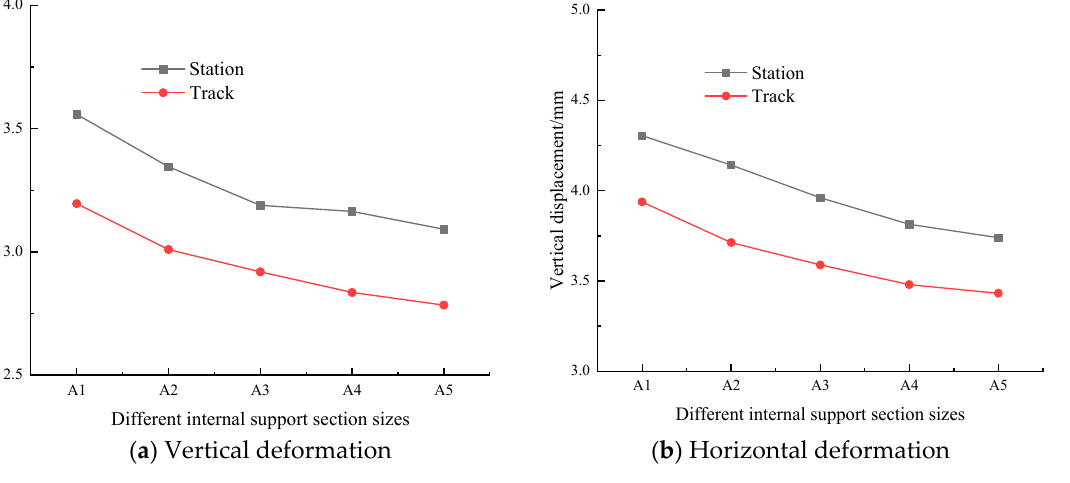
Figure 27. Maximum vertical and horizontal deformation values of stations and tracks under different interbracing section sizes.